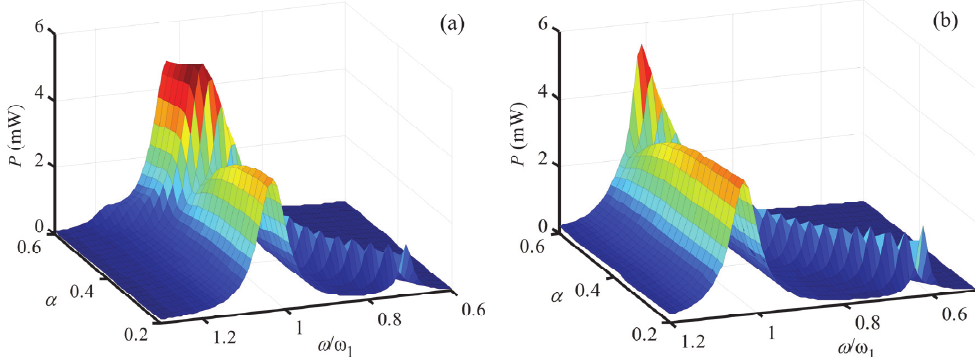
Figure 6. Output power versus excitation frequency for different α : ( a ) μ = 0.46; ( b ) μ = 0.60.